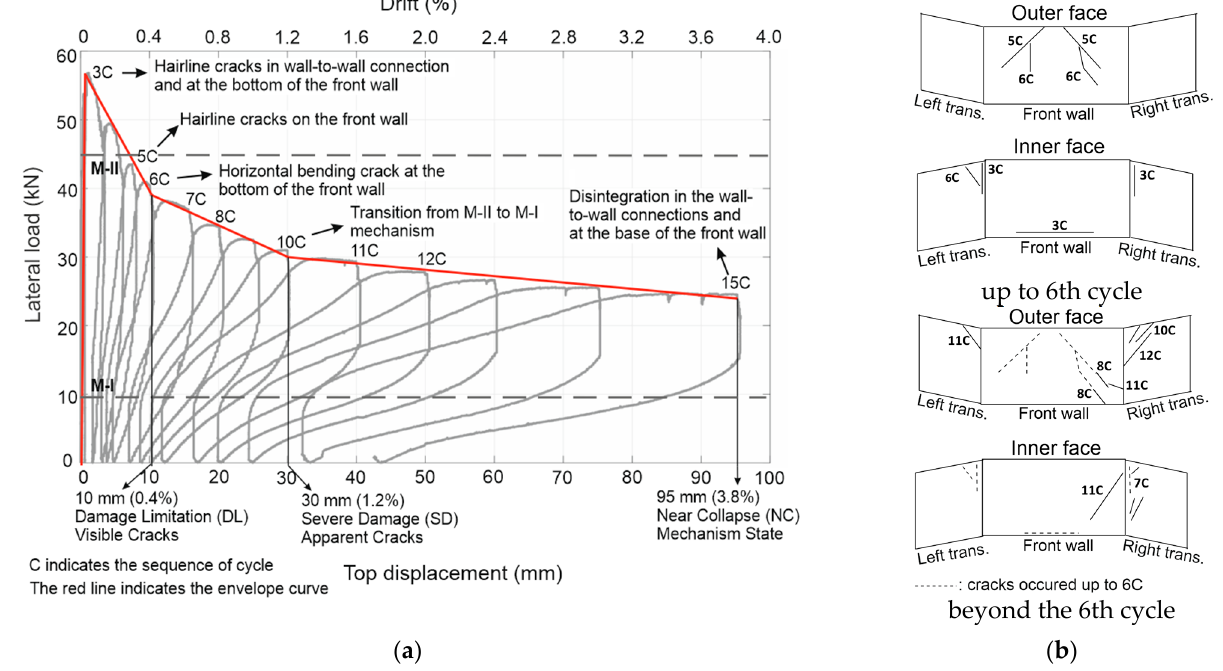
Figure 7. ( a ) Load–drift response, and ( b ) crack pattern in the DMW specimen [15].